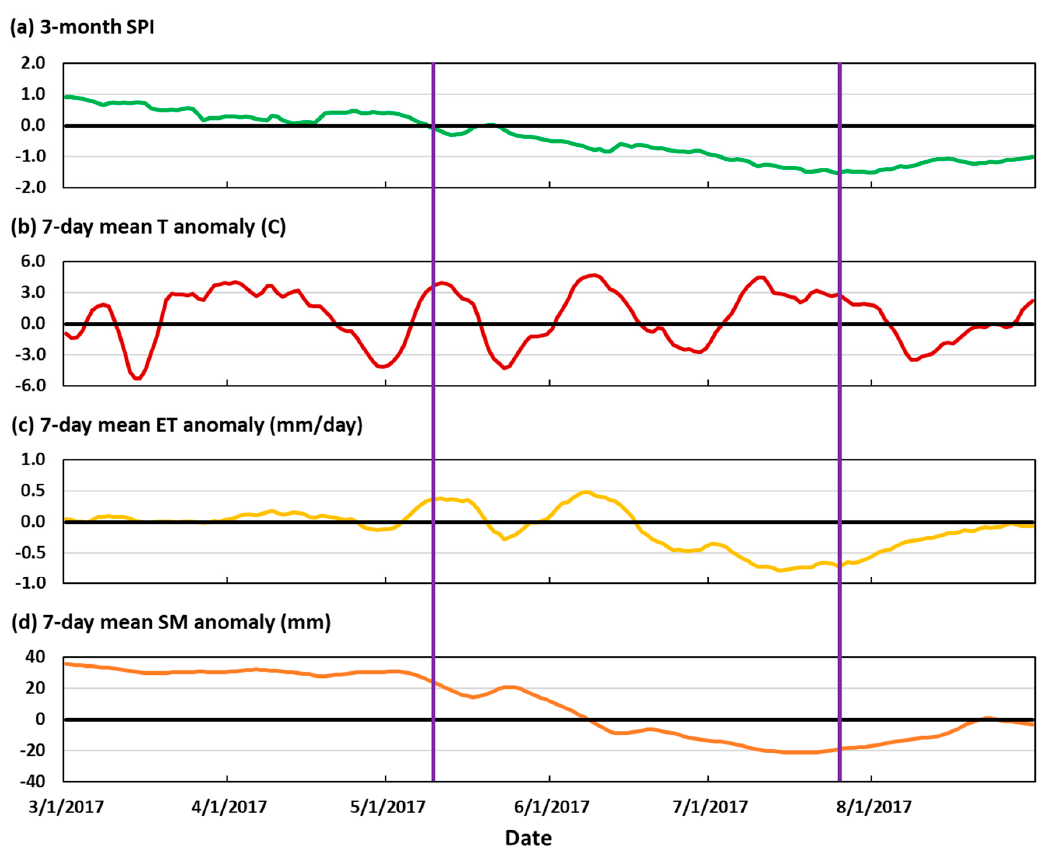
Figure 3. Time series of ( a ) 3-month SPI, ( b ) 7-day mean temperature anomaly, ( c ) 7-day mean evapotranspiration anomaly, and ( d ) 7-day mean soil moisture anomaly averaged over the Northern High Plains region (shown in Figure 1) from 1 March to 31 August 2017. The time period within the vertical purple lines is the fast-development period.